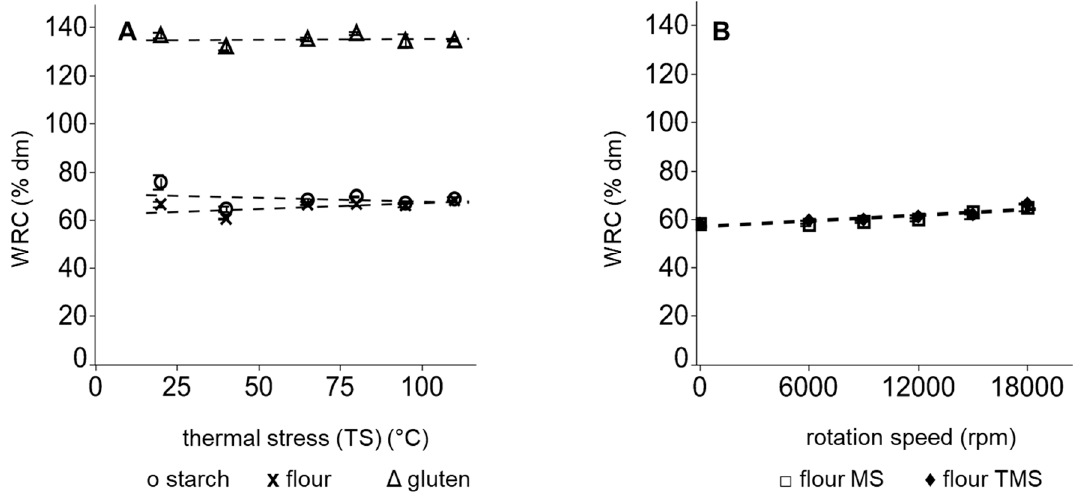
Figure 6. Mean water retention capacity after ( A ) exclusively thermal treatment of flour x, starch O and gluten Δ and ( B ) after mechanical treatment with thermal stress (TMS) ♦ or without thermal stress (MS) ≤ of wheat flours. Error bars represent standard deviations; n = 3